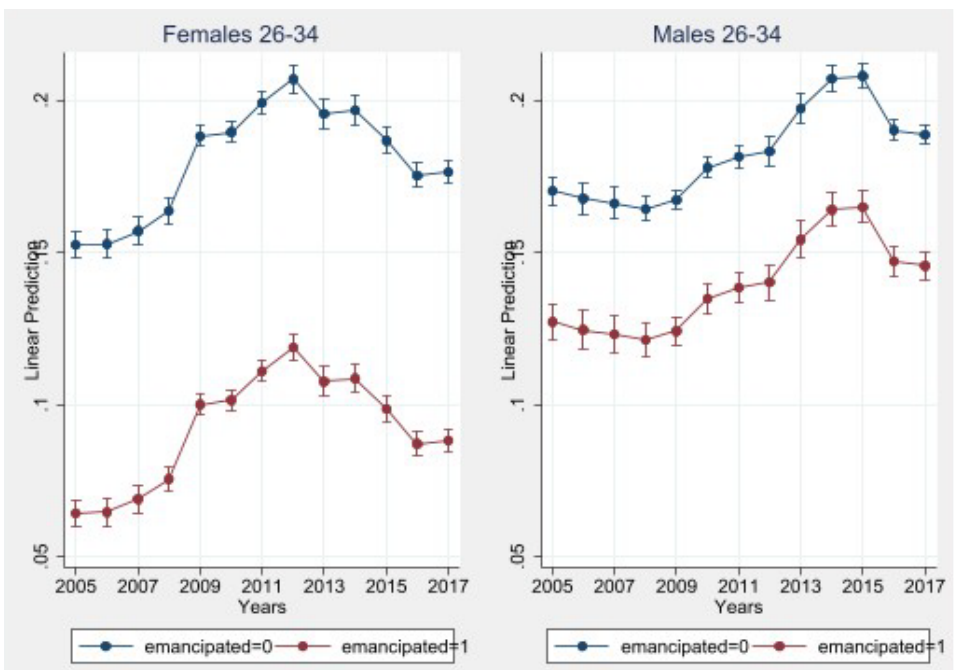
Figure 9 : Predicted employment deprivation levels of other cohabiting household members for youth between 26-34 years of age living in and out of the parental home. Spain.